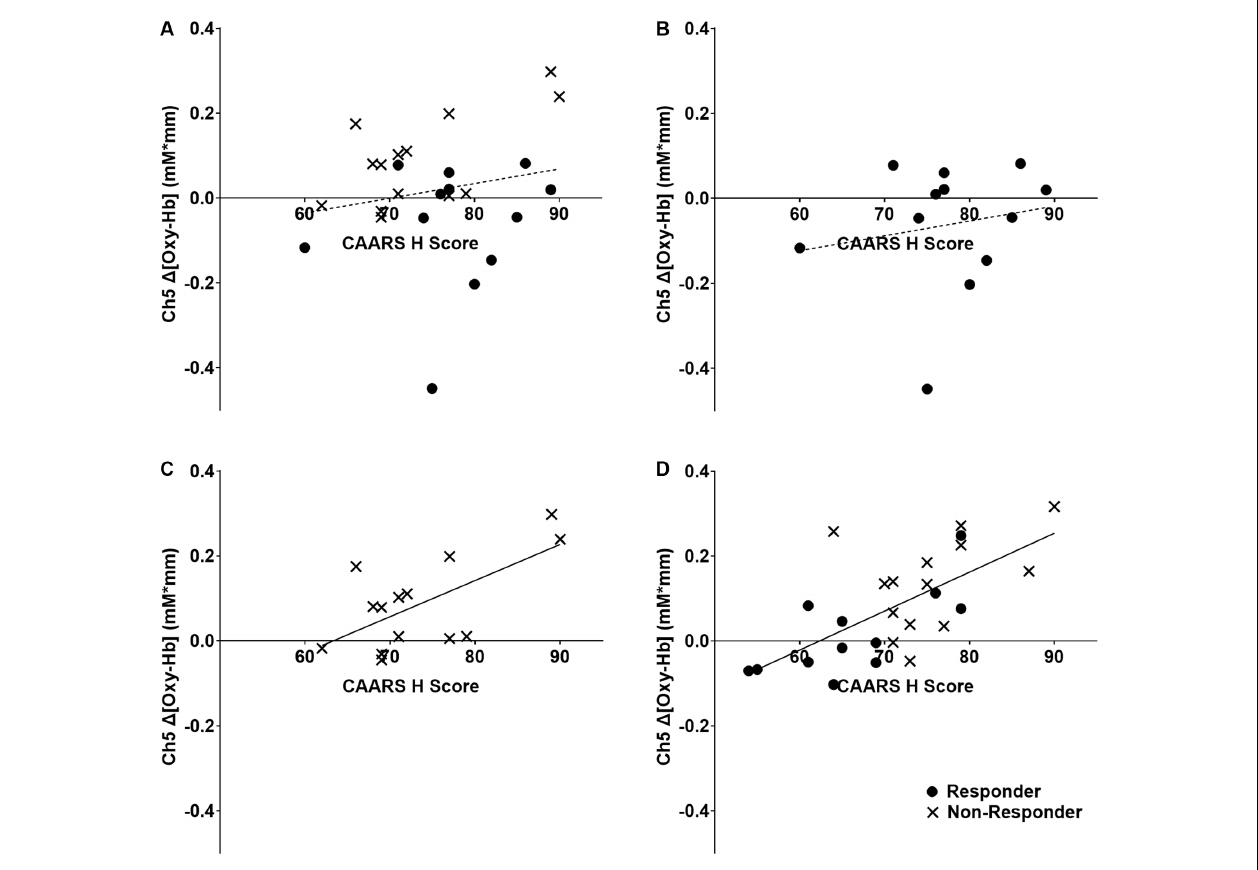
FIGURE 2 | Relationship between right dorsolateral prefrontal cortex activity and clinical ADHD symptoms. The dashed line indicates that there is no significant correlation, and the solid line indicates that there is a significant correlation. The regression lines refer to all individuals in the panel, including both responder and non-responder groups. (A) All participants at baseline, r = 0.129, p = 0.522. (B) ATX-responder group at baseline, r = 0.179, p = 0.579. (C) ATX non-responder group at baseline, r = 0.646, p = 0.013. (D) All participants at 8 weeks, r = 0.694, p < 0.001. ADHD, attention-deficit hyperactivity disorder; ATX,